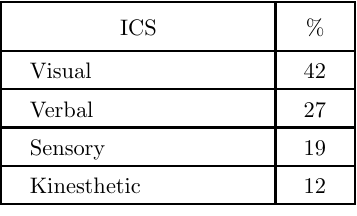
Cognitive Architecture of the Law Student’s